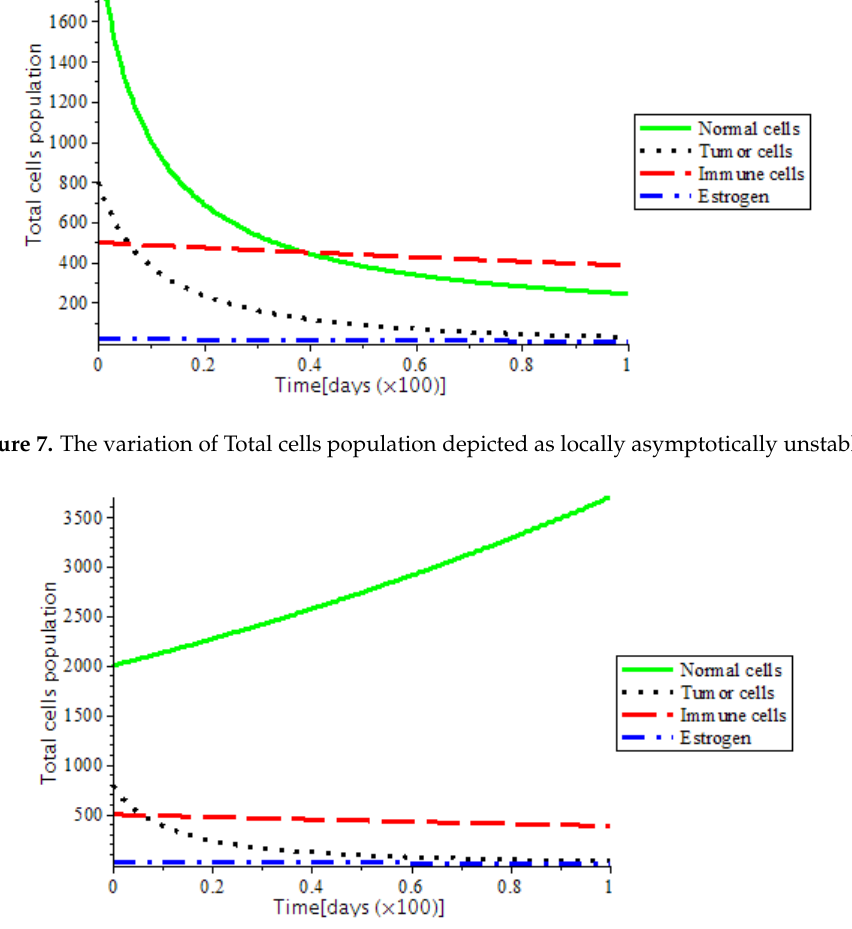
Figure 8. The variation of Total cells population depicted as locally asymptotically stable